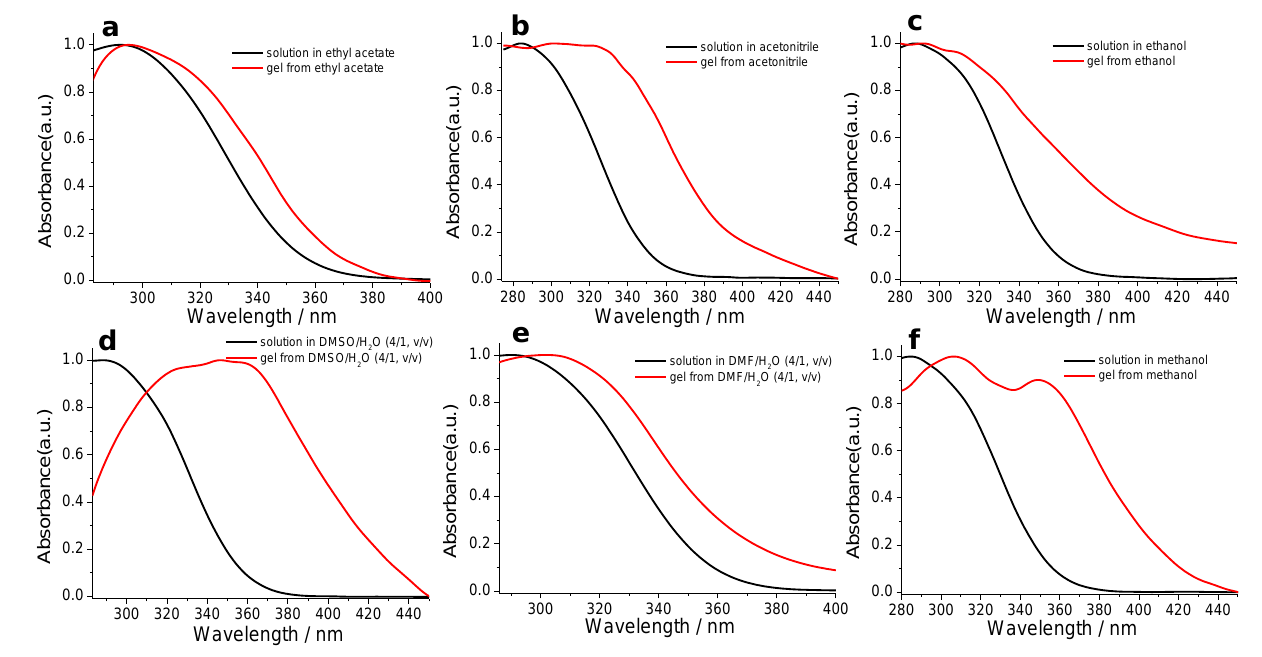
Figure 3. UV–vis absorption spectra of gelator 1 in solution and gel state with different solvents: ( a ) ethyl acetate; ( b ) acetonitrile; ( c ) ethanol; ( d ) DMSO/H 2 O (4/1, v / v ); ( e ) DMF/H 2 O (4/1, v / v ); ( f ) methanol. The concentrations of solution and gel were 10 − 5 M and the corresponding CGC. To explore the effect of solvents on gelator 1 , fluorescence emission spectra of 1 in solution and gel states with six different solvents were investigated (Figure 4). In Figure 4a, solution 1 in ethyl acetate had a maximum emission peak at 402 nm with a very weak intensity, and was blue-shifted to 397 nm in the gel state, indicating the TICT behavior of gelator 1 in ethyl acetate [62]. Solution 1 in acetonitrile almost did not emit light, and an emission peak was at 393 nm for its gel state (Figure 4b). Similar emission behavior was observed for the gel of 1 in ethanol (Figure 4c). An emission at 342 nm of solution 1 in DMSO/H 2 O (4/1, v / v ) was red-shifted to 393 nm with a shoulder peak of 376 nm in the gel state, which showed that π – π stacking was presented in the gel system. Two emission peaks appeared at 339 and 415 nm for solution 1 in DMF/H 2 O (4/1, v / v ), which combined into a single broad peak at 378 nm in the gel state (Figure 4e). Two emission peaks at 358 and 393 nm of solution 1 in methanol were also changed into one peak at 373 nm in the gel state (Figure 4f). These experimental results exhibited that the solvent not only affected the self-assembly process, but also influenced the emissions. An X-ray powder diffraction experiment can provide some information about the self-assembly patterns in gel [63]. Xerogels of 1 were explored by the XRD experiment (Figure S1). As shown in Figure S1a,a (cid:48) , the XRD pattern of the xerogel of 1 in acetonitrile showed a series of diffraction peaks with the d -space values of 2.69, 1.35, 0.84, 0.76, 0.67, 0.59, 0.56, 0.50, 0.45, 0.43, 0.40, 0.36, 0.34 and 0.31 nm. The d -space values of 2.69, 1.35 and 0.67 nm were at the ratio of 1: 1/2: 1/4 and indicated that gelator 1 was self-assembled into a layered structure with a layer distance of 2.69 nm, which was close to the molecular length of gelator 1 and showed the monomolecular self-assembly. The similar diffraction peaks and d -space values were also presented in other XRD patterns of the xerogels of 1 , indicating that the self-assembly of gelator 1 in gel systems was highly ordered (Figure S1b–f,b (cid:48) –f (cid:48) ). The XRD pattern of the powder of 1 showed only one diffraction peak at 2 θ = 20 ◦ , which indicated that molecule 1 in powder was not in orderly arrangement such as that of the gel state (Figure S1g,g (cid:48) ). It is well known that there are one or more driving forces, such as a hydrogen bond and van der Waals force, in the self-assembly gel [64]. In order to analyze hydrogen